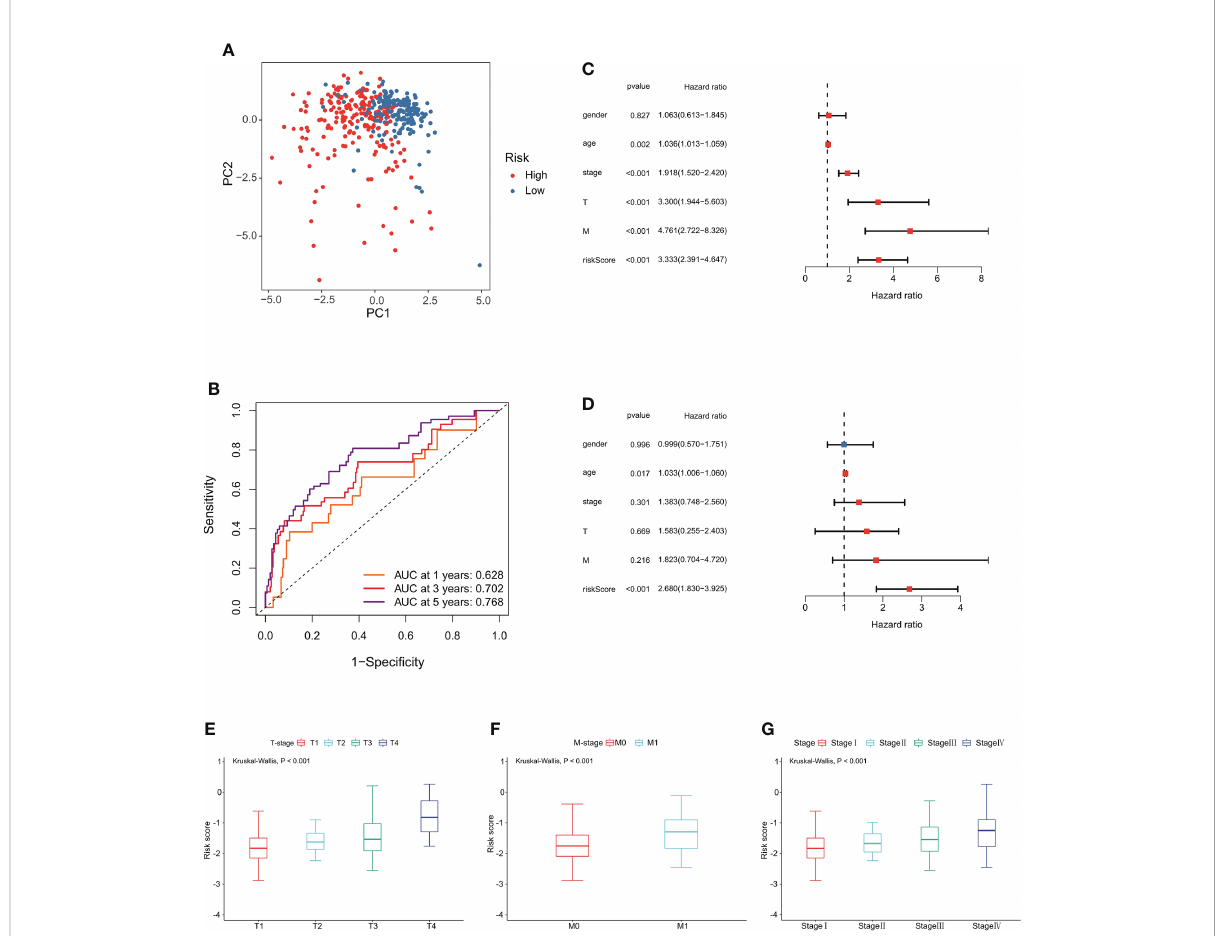
FIGURE 4 Evaluation of the PCRG prognostic signature. (A) The low-risk and high-risk groups can be separated into two parts using PCA. (B) Time- dependent ROC curves for the risk score for predicting 1-, 3-, and 5-year survival in the TCGA-KIRC cohort. (C) Univariate Cox and (D) multivariate Cox regression analyses of age, sex, grade, stage, T stage, M stage, and risk score. Relationship between the risk score and (E) T stage, (F) M stage, and (G)